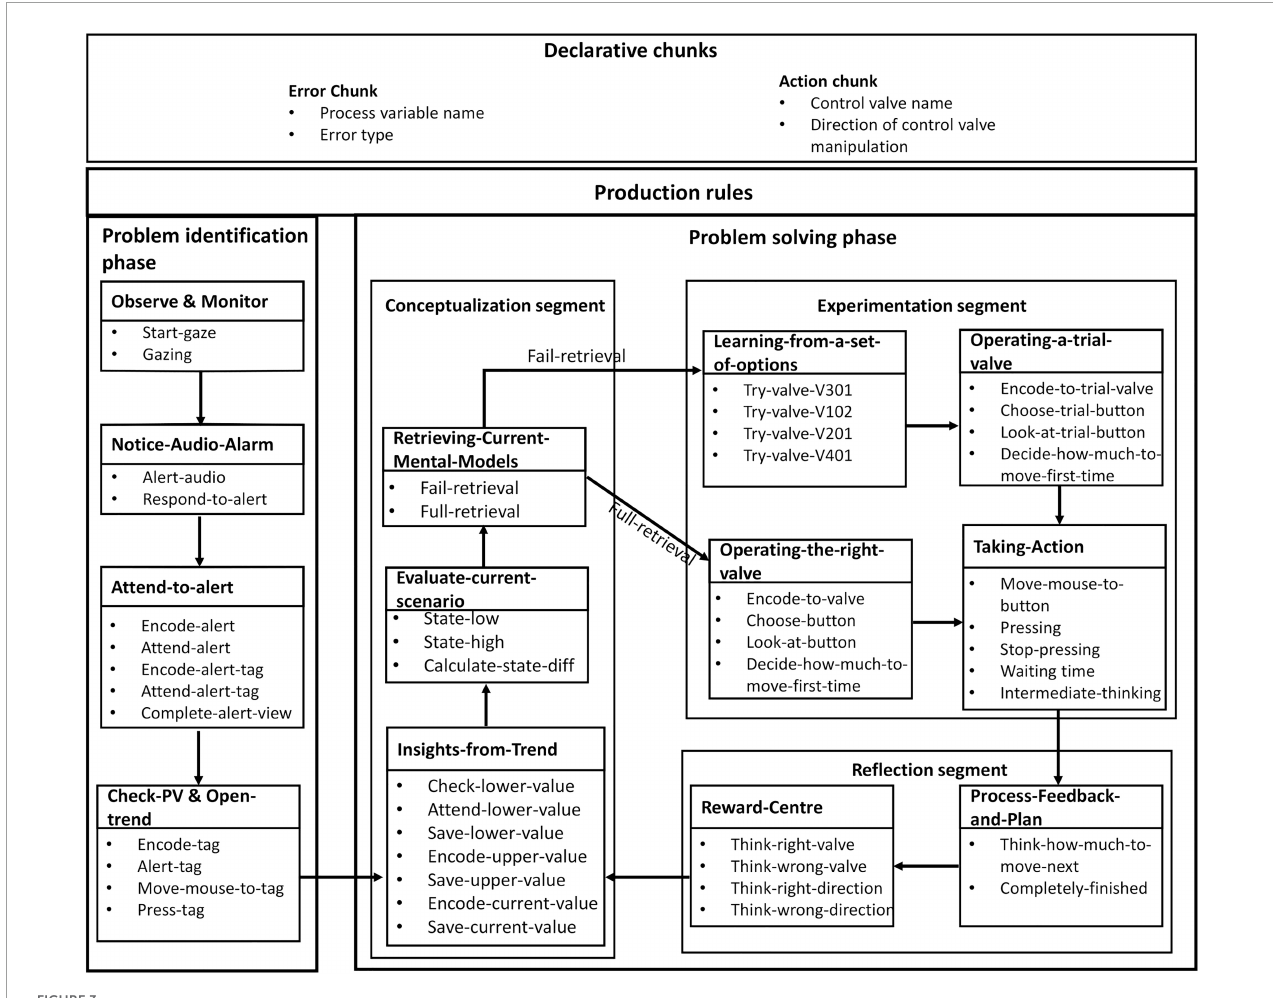
FIGURE3 Production rules in the human digital twin of process